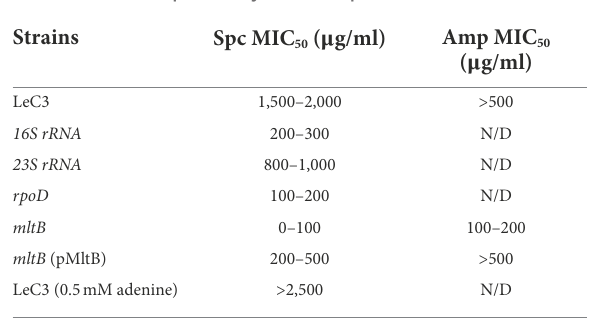
TABLE 2 Minimum inhibition concentration 50 (MIC 50 ) of LeC3 and its derived strains for spectinomycin and ampicillin.